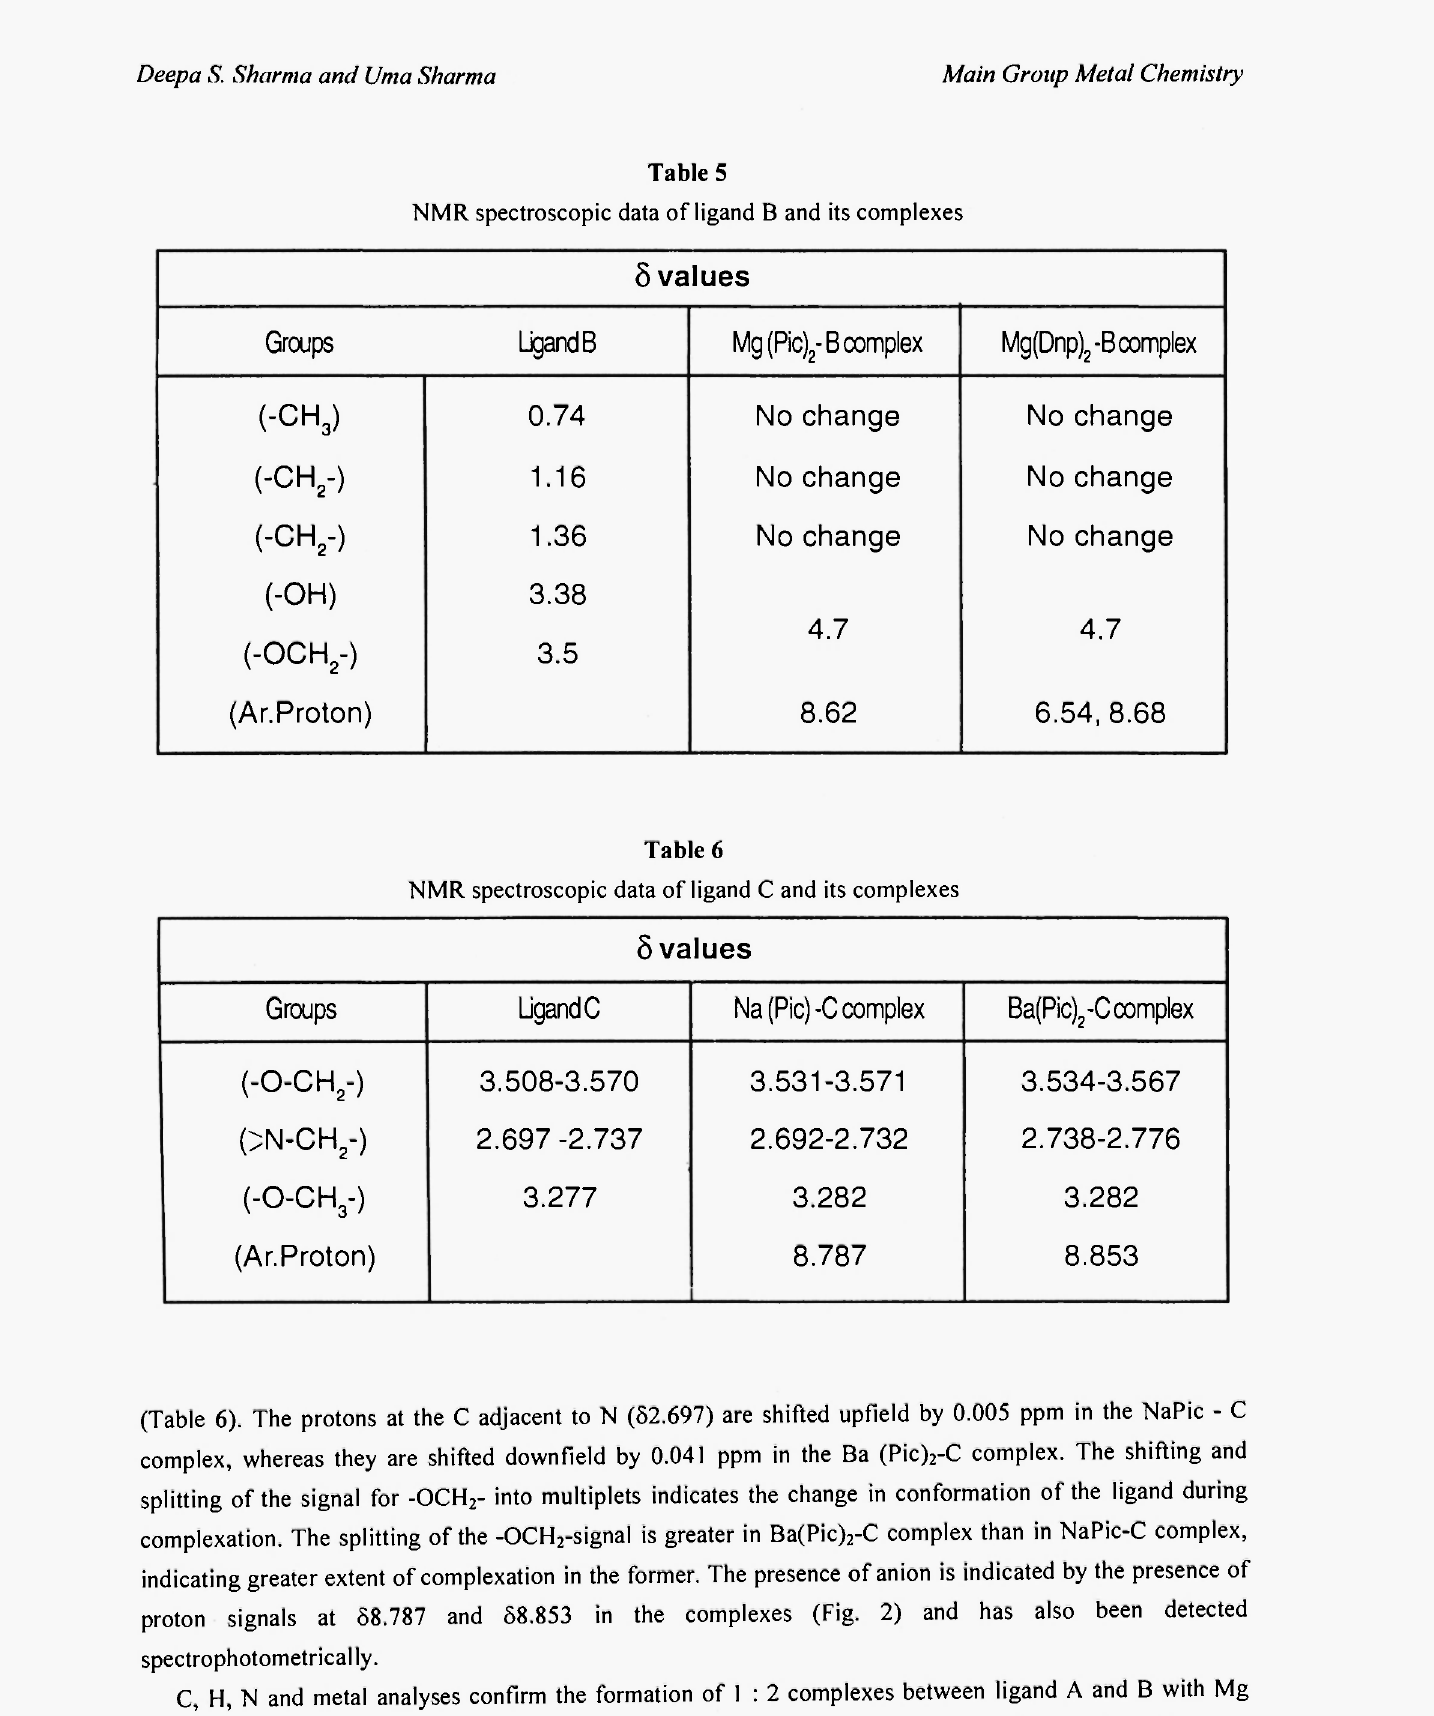
NMR spectroscopic data of ligand Β and its